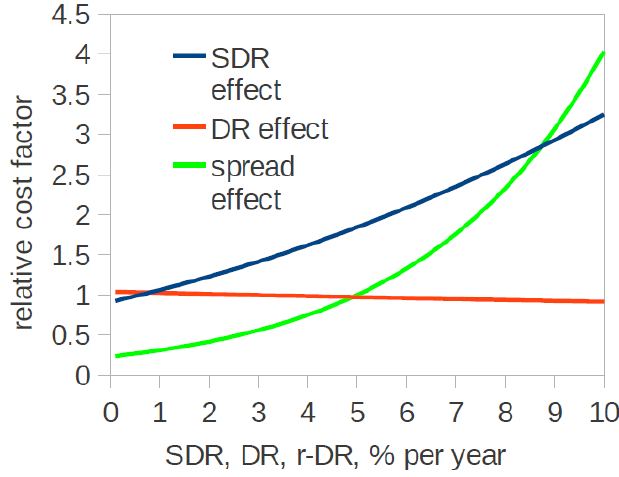
Figure 2. The effect on cost of system degradation rate (blue), discount rate (red), and credit spread (green). The curves are normalized to the cost at r-DR = 5%, SDR = 0.6%, and DR =